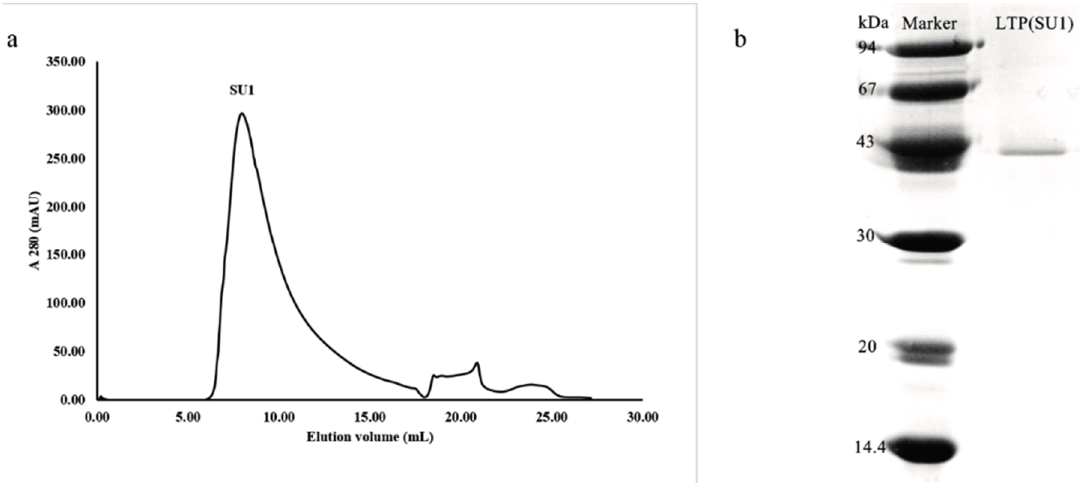
Figure 2. ( a ) FPLC-gel filtration on Superdex 75 10/300 GL column and ( b ) SDS-PAGE of fraction SU1. a Eluent: 10 mM Tris-HCl buffer (pH 7.5). Fraction size: 0.8 mL. Flow rate: 0.5 mL·min − 1 . Fraction SU1 represents purified ACE inhibitory protein; b SDS-PAGE of fraction